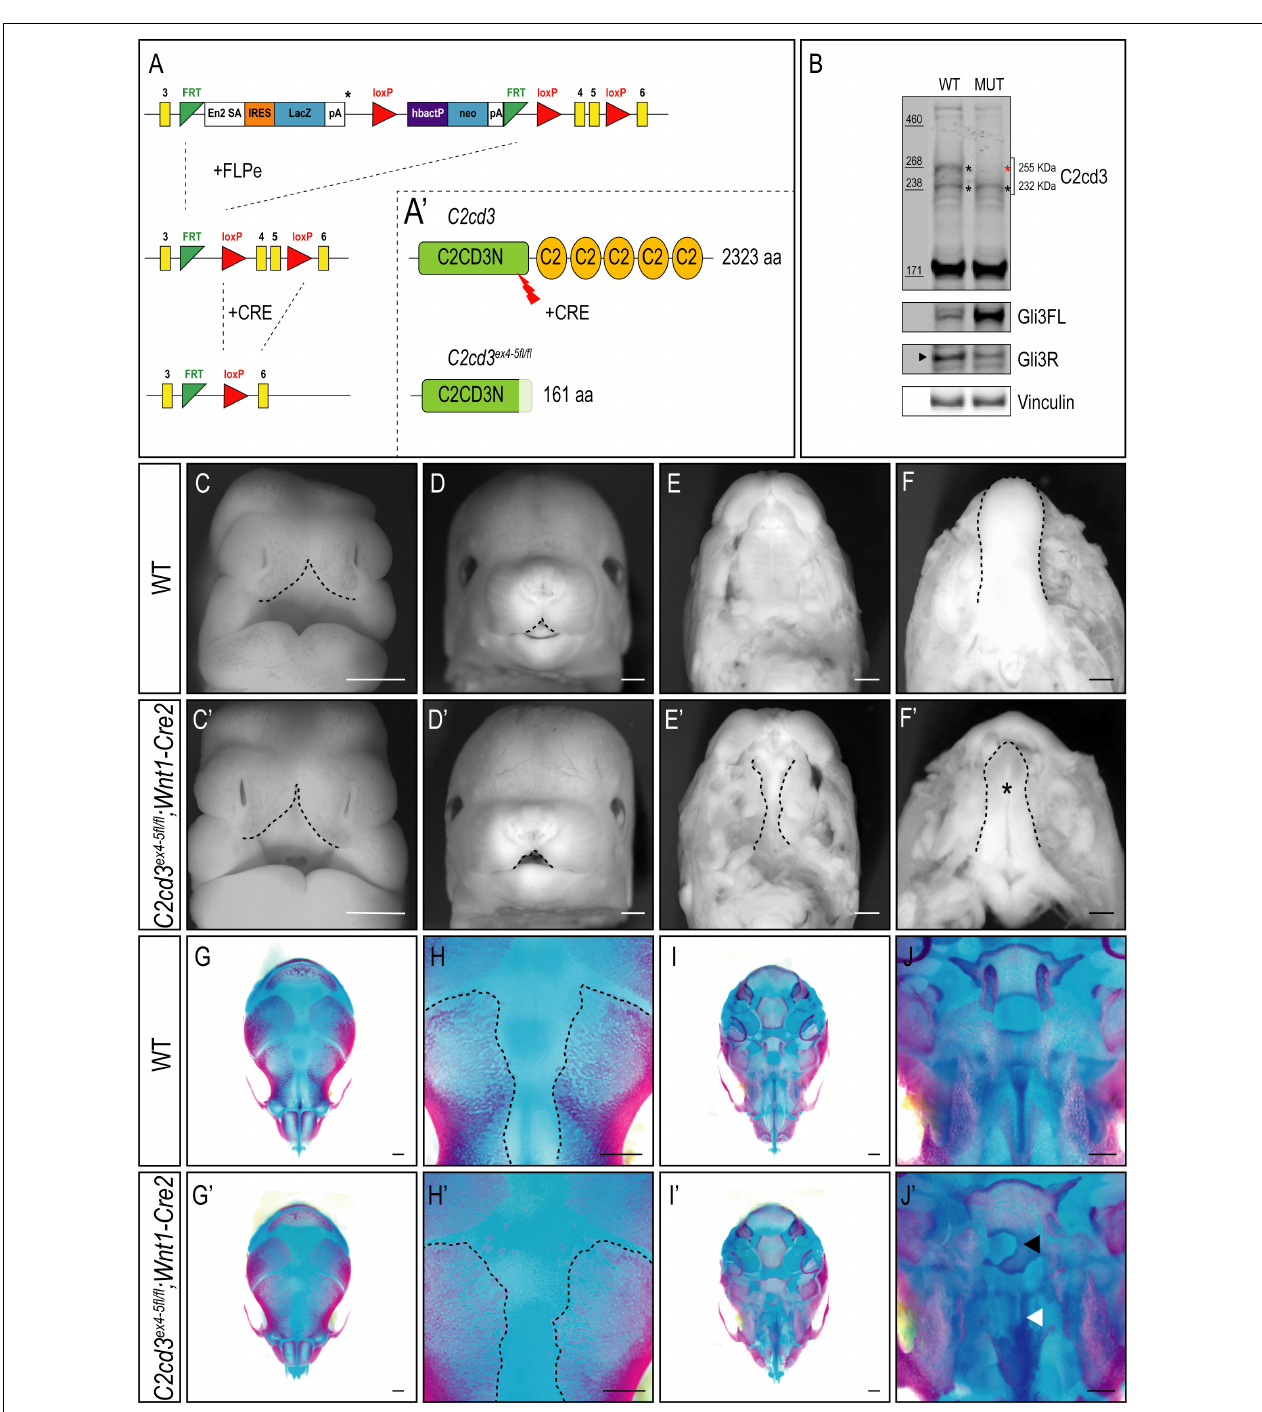
FIGURE 4 | Conditional loss of C2CD3N-C2 domain results in craniofacial phenotypes. (A,A (cid:48) ) C2cd3 LacZ mice were bred to FLPeR mice to excise the LacZ expression cassette, resulting in C2cd3 ex4 - 5flox progeny with LoxP sequences flanking exon 4 and 5 and generating a protein with a truncated C2CD3N-C2 domain. (B) Western blot of C2cd3 expression in E11.5 facial prominences showing deletion of the longest C2cd3 isoform 255 kDa in and C2cd3 ex4 - 5fl / fl ; Wnt1-Cre (red asterisk, n = 4 for both wild type and mutant, not shown). (C,C (cid:48) ) C2cd3 ex4 - 5fl / fl ;Wnt1-Cre2 embryos have characteristic midline widening (dotted line) at E11.5 compared to wild-type, which is exacerbated at E15.5 [ (D,D (cid:48) ) , dotted lines], as well as cleft palate [ (E,E (cid:48) ) , dotted line] and a hypoplastic tongue [ (F,F (cid:48) ) , asterisk]. (G,G (cid:48) ) Dorsal views of skull. E18.5 C2cd3 ex4 - 5fl / fl ;Wnt1-Cre2 embryos have normal frontal bone and frontal suture (H,H (cid:48) ) development. (I,I (cid:48) ) Ventral views of skull. E18.5 C2cd3 ex4 - 5fl / fl ;Wnt1-Cre2 embryos present with abnormal bone growth of the sphenoid [ (J,J (cid:48) ) , black arrowhead] and palatine bone [ (J,J (cid:48) ) , white arrowhead]. Scale bars: 0.5 mm.